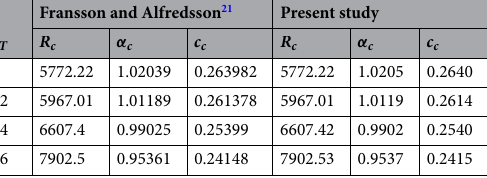
Table 2. Comparison of ( R c , α c , c c ) between the present study and Fransson and Alfredsson 21 for different values of R T .